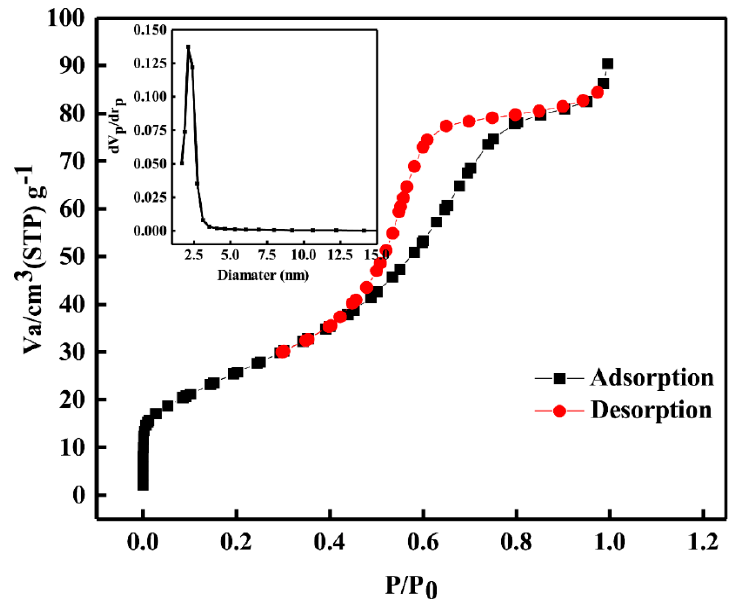
Figure 2. N 2 adsorption–desorption curve of MoZr calcinated at 600 °C.